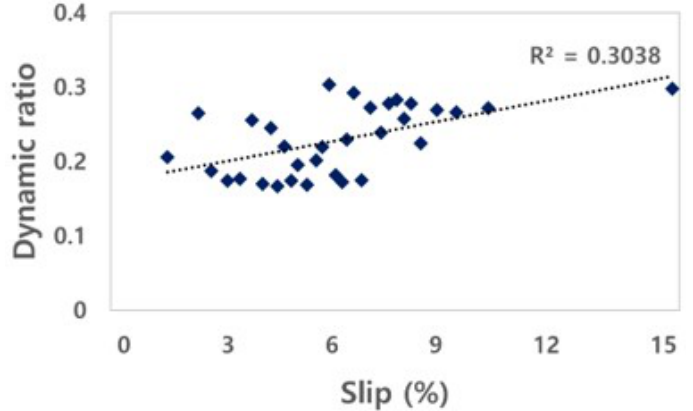
Figure 11. Results of dynamic ratio as slip for the electric AWD tractor during traction test.